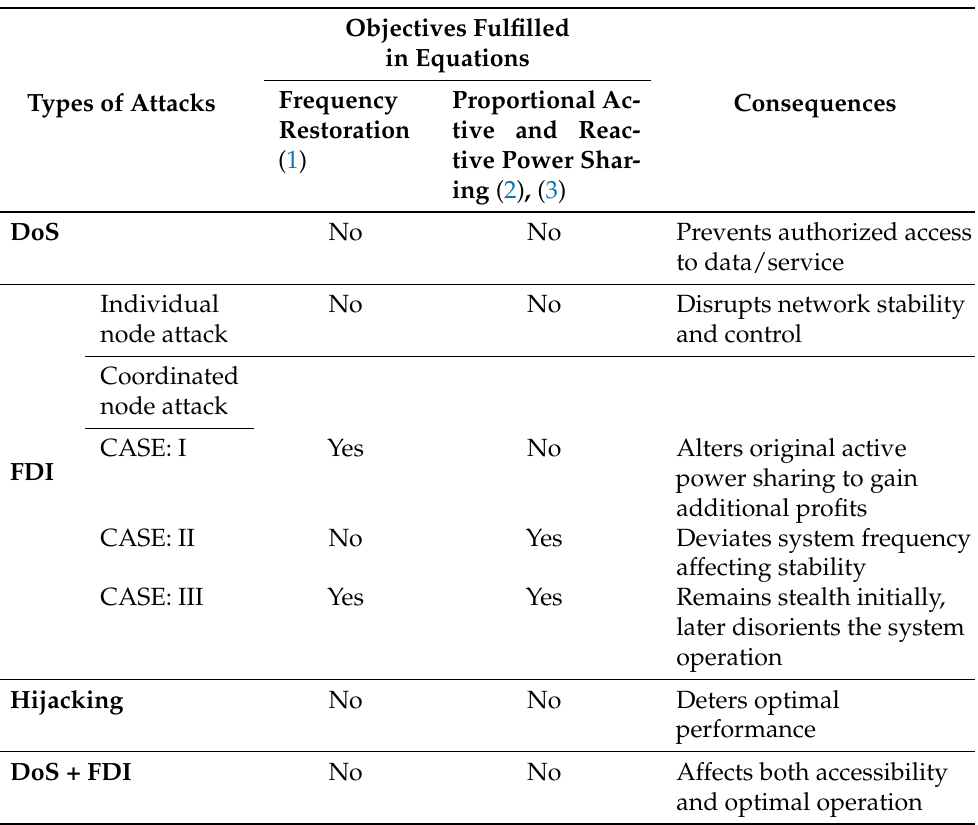
Table 4. Outcomes of various